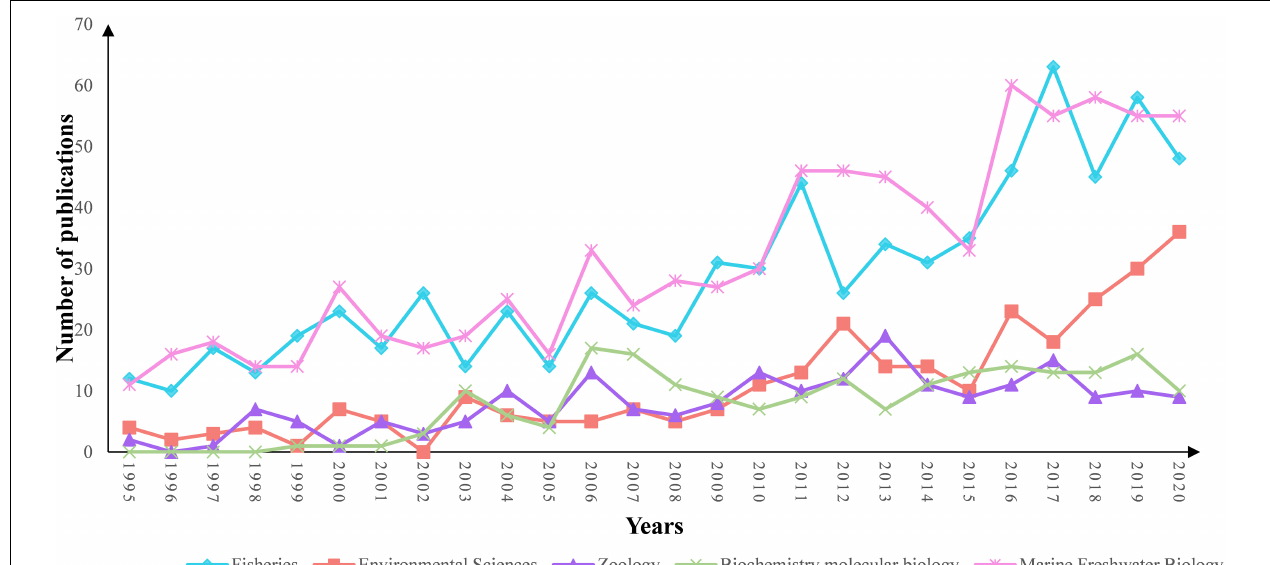
FIGURE 2 | Comparison of the growth trends of the top five productive subject categories.